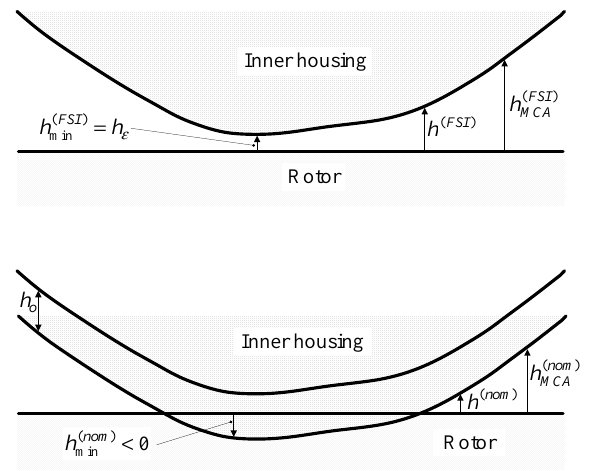
Figure 9: The simulated pressure distribution (a) and the deflection of the inner housing (b) to one test condition of the prototype motor.